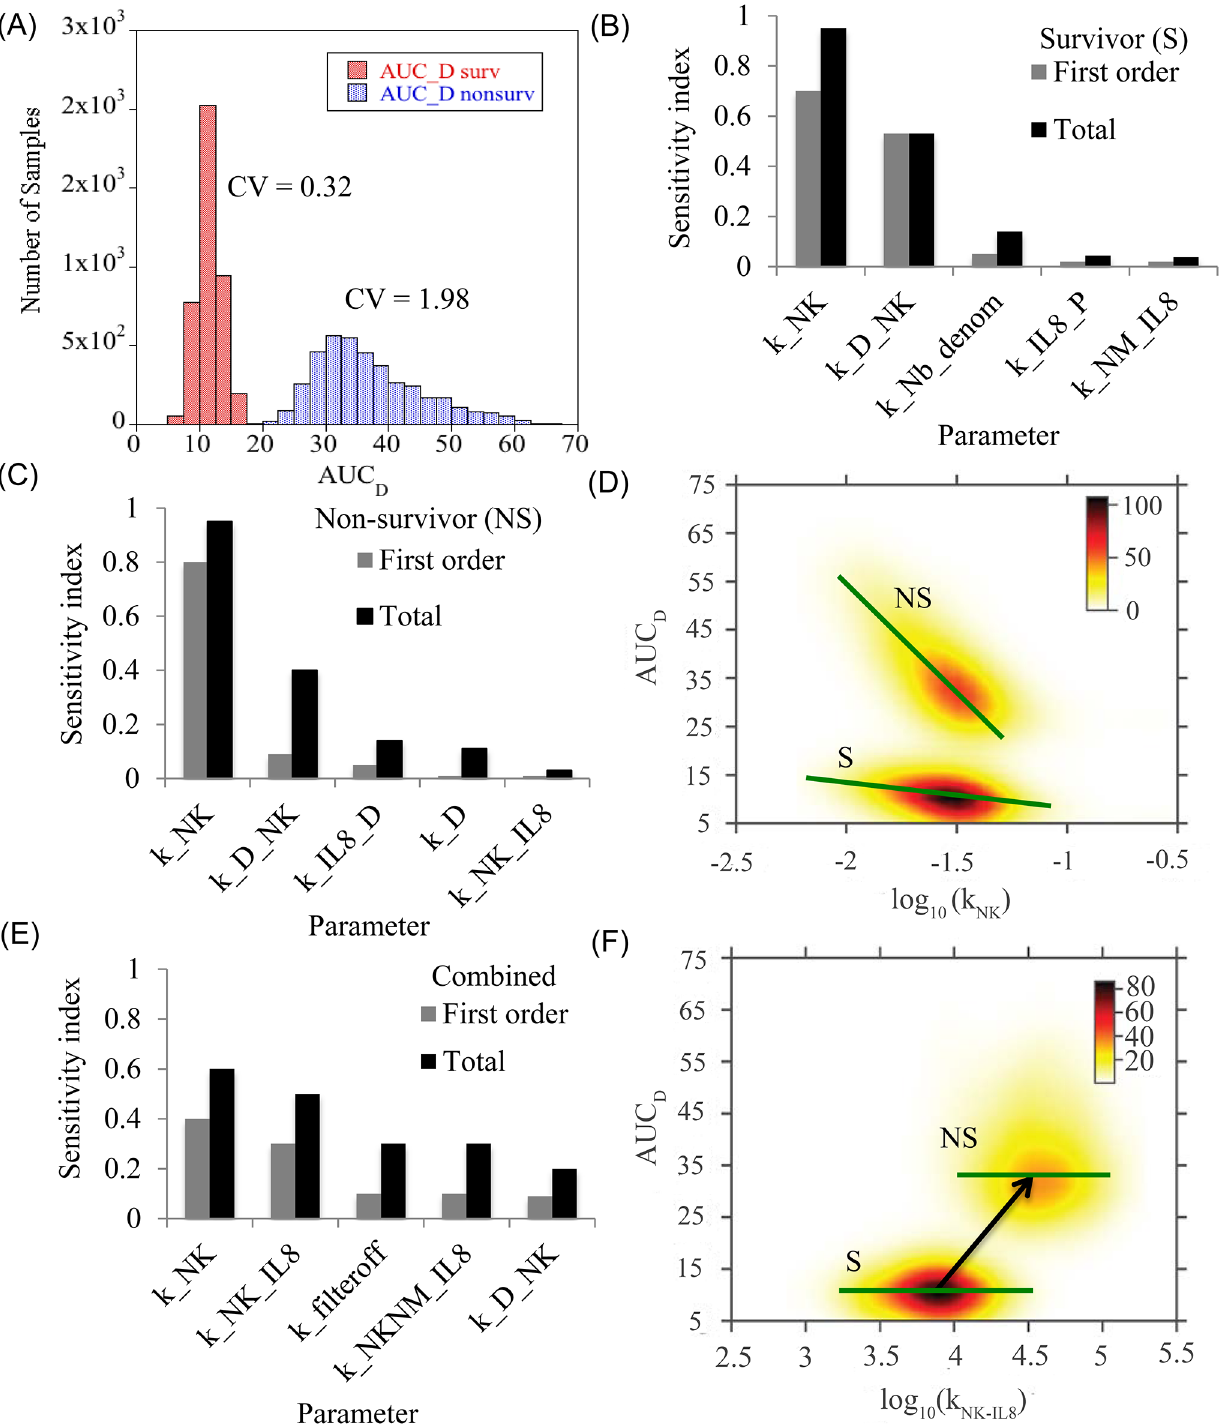
Fig 6. Factors affecting cumulative systemic damage. (A) Cumulative damage seen in survivors and non-survivors. The histograms show the area under the damage curve until 144 hr. The rate parameters were sampled from the generated ensemble for each population. The distribution used for GSA contains 4000 samples for each population. (B-C) Prime drivers of cumulative damage. First order and total effect Sobol ’ indices which explained most of the variance are tabulated here for the survivor and non-survivor population respectively. (D) Functional dependence of AUC D on killer cell decay rate for the survivors (S) and non-survivors (NS). The green line has been added for visual guidance of the trend and is based on the mean trend identified by the